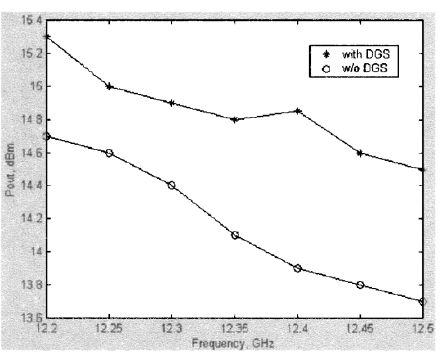
FIGURE 6 Measured output power of VCOs. The bias conditions are V varactor ¼(cid:1) 10V, V GS ¼(cid:1) 1V, V DS ¼ 5V, and I DS ¼ 45mA.